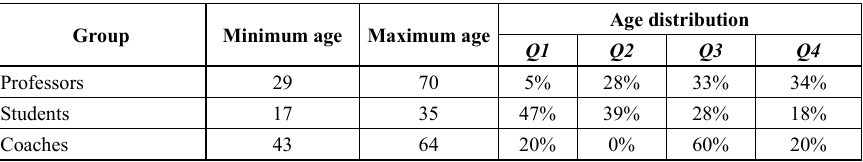
Table 2. Participants’ characteristics (age profile)